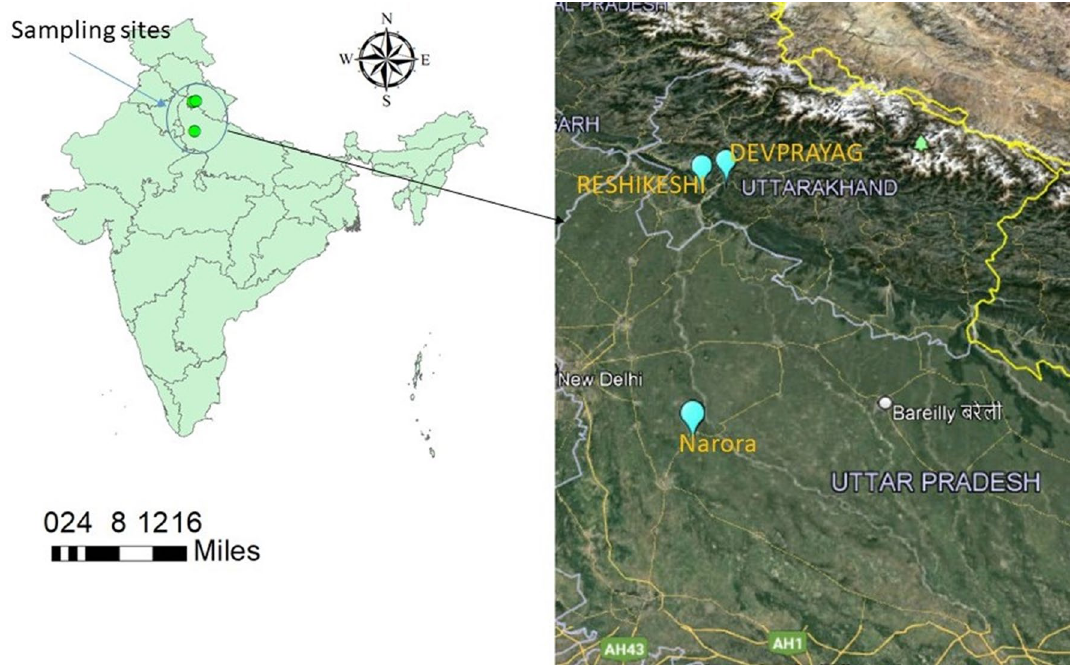
Figure 1. Map showing sampling stations (Devprayag, Rishikesh and Narora) along the length of river Ganga (source Google earth).